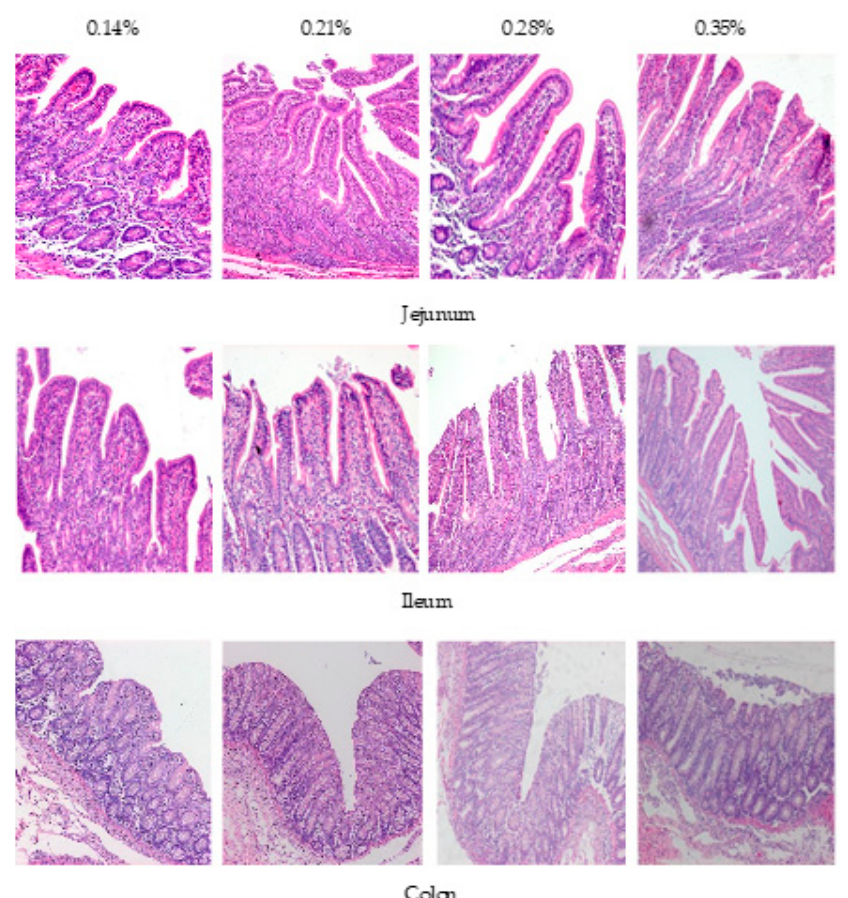
Figure 1. Effects of dietary tryptophan levels on the mucosal morphology of the jejunum, ileum, and colon of weaned piglets (400×).